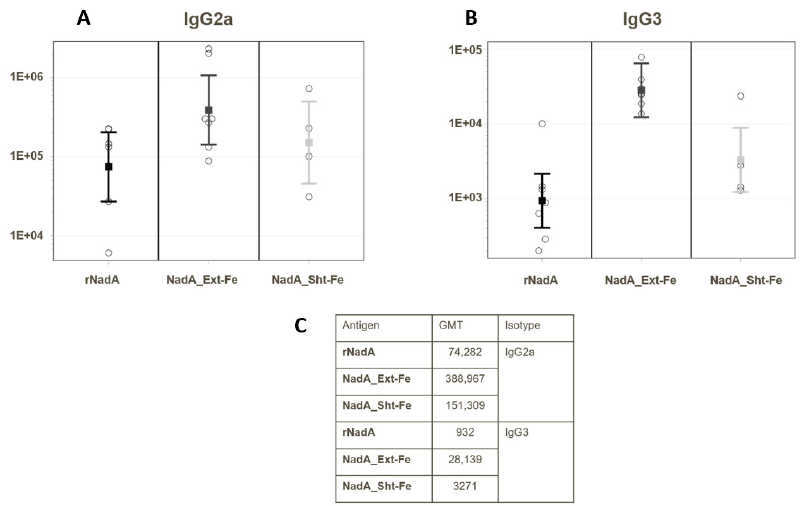
Figure 5. Immunoglobulin subclasses induced by immunization with rNada, NadA_Ext-Fe, and NadA_Sht-Fe. Geometric mean titers (GMT) of ( A ) IgG2a and ( B ) IgG3 induced in mice by vaccina- tion with uncoupled recombinant NadA (rNadA) and the two ferritin-coupled NadA constructs. ( C ) Values of the GMT data plo tt ed in panels ( A , B ). Mouse ID 75 was excluded from the analysis as an outlier (Dixon’s test for a single outlier was applied).